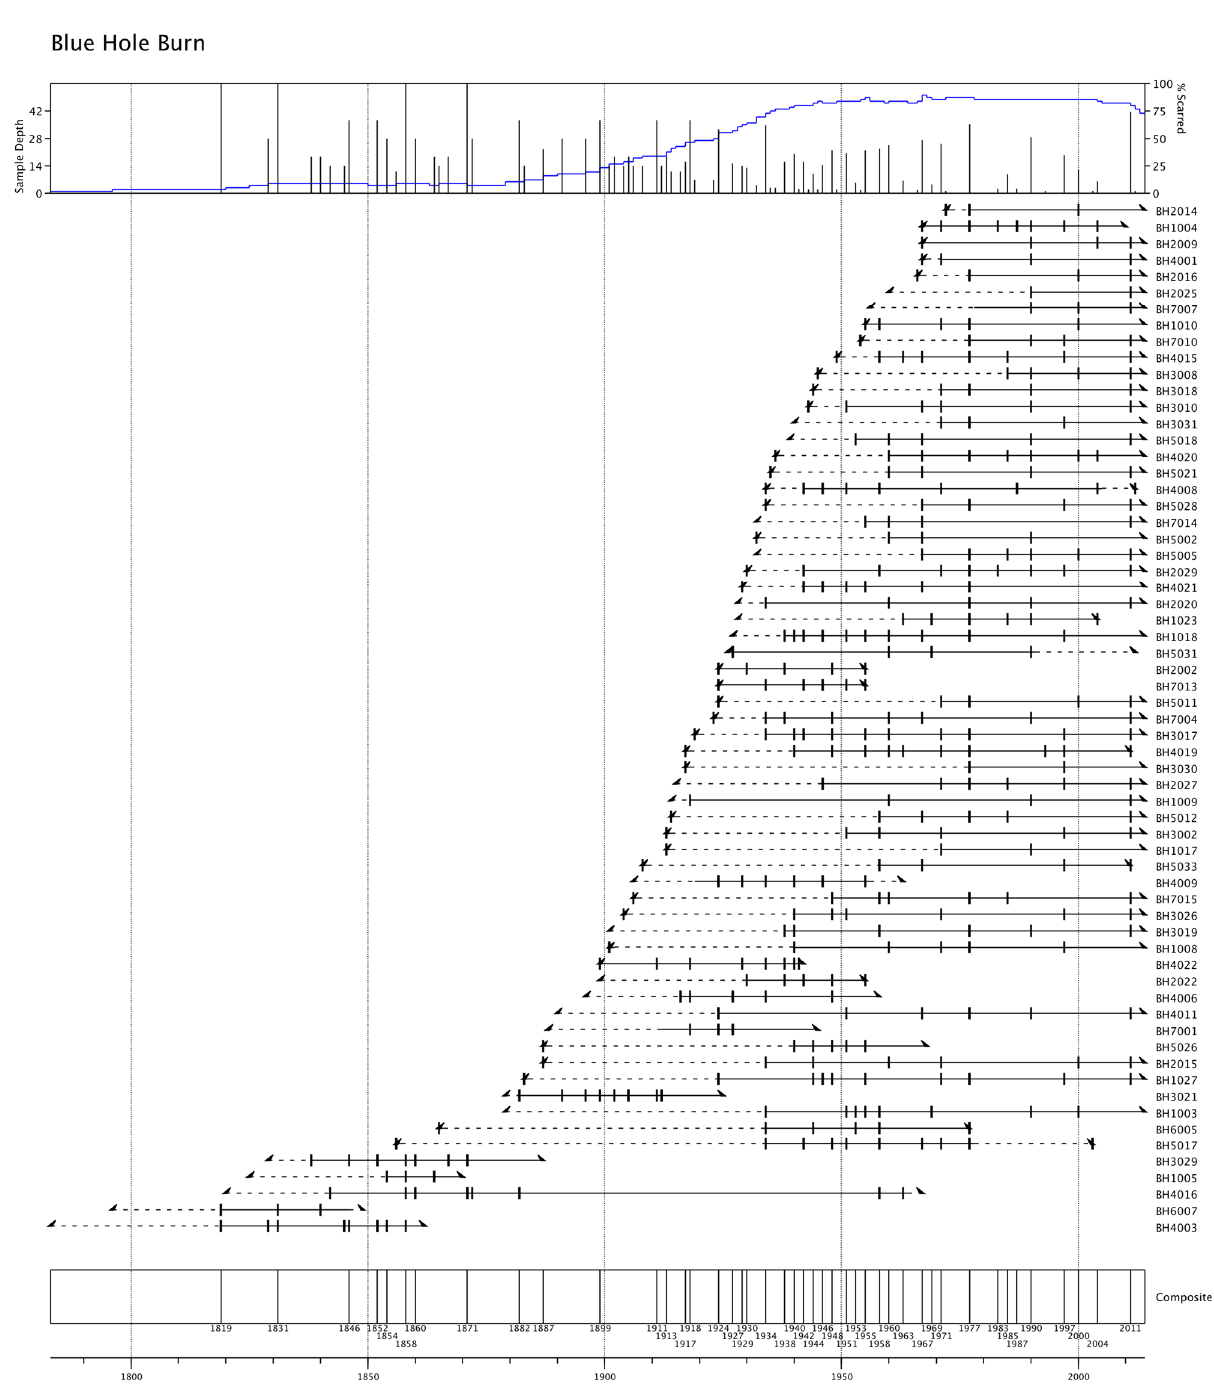
Figure 2. Fire history of the Blue Hole site ( n = 63). A high-resolution copy and raw fire-scar data are provided in supplemental materials to view this graph with finer clarity.